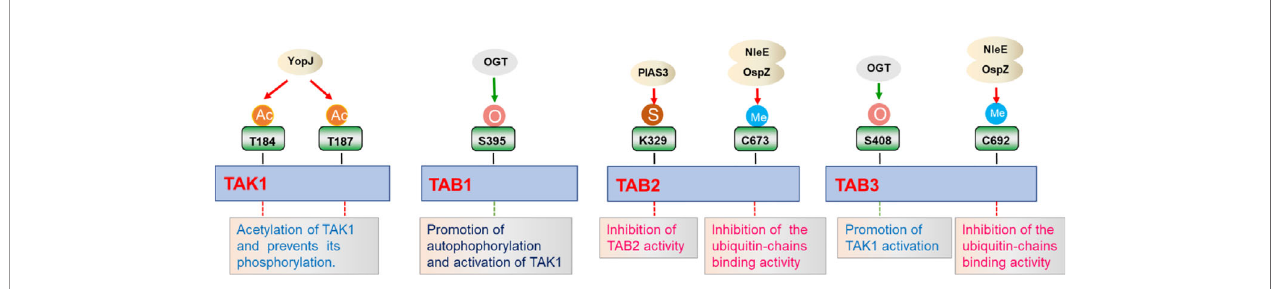
FIGURE 4 | Regulation of TAK1-TABs complex by different post-translational modi fi cations. TAK1-TABs complex is modi fi ed by various post-translational modi fi cations including acylation (Ac), methylation (Me), sumoylation (S), and O-GlcNAcylation (O), which regulates the activation and the assembly of the complex in response to